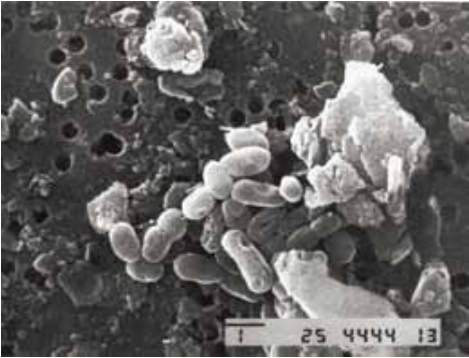
Figure 6. Microbes from Vostok ice core, depth of 2395 m, magnification x14,000 (Bobin et al., 1994).